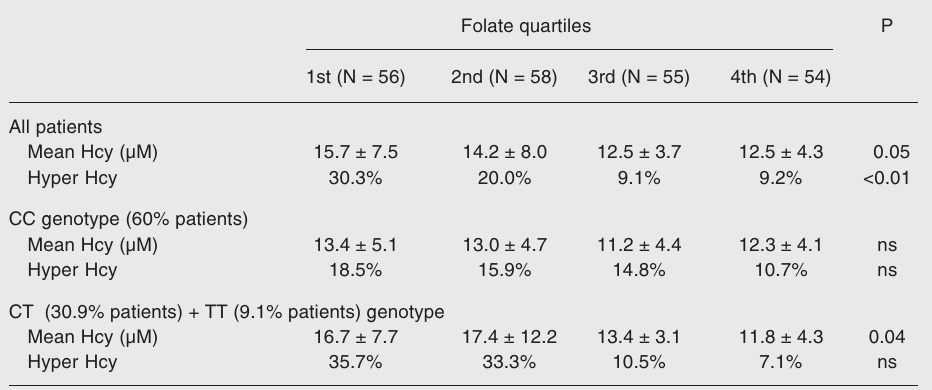
Table 3. Comparison between patients with poor (bottom quartile: ≤ 4.9 ng/dL) and high (top quartile) folate status in terms of mean plasma homocysteine (Mean Hcy) levels and frequency of hyperhomocystinemia (Hyper Hcy) according to MTHFR